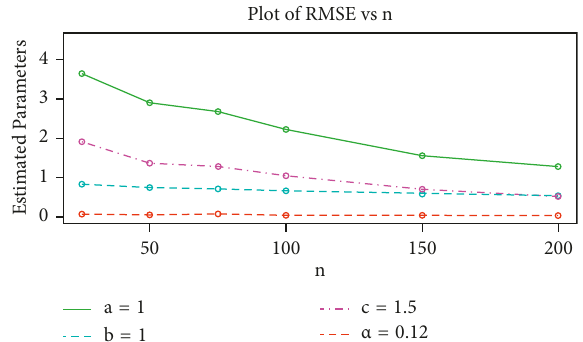
Figure 3: The plots of ABs for the ExEW parameters in set I.